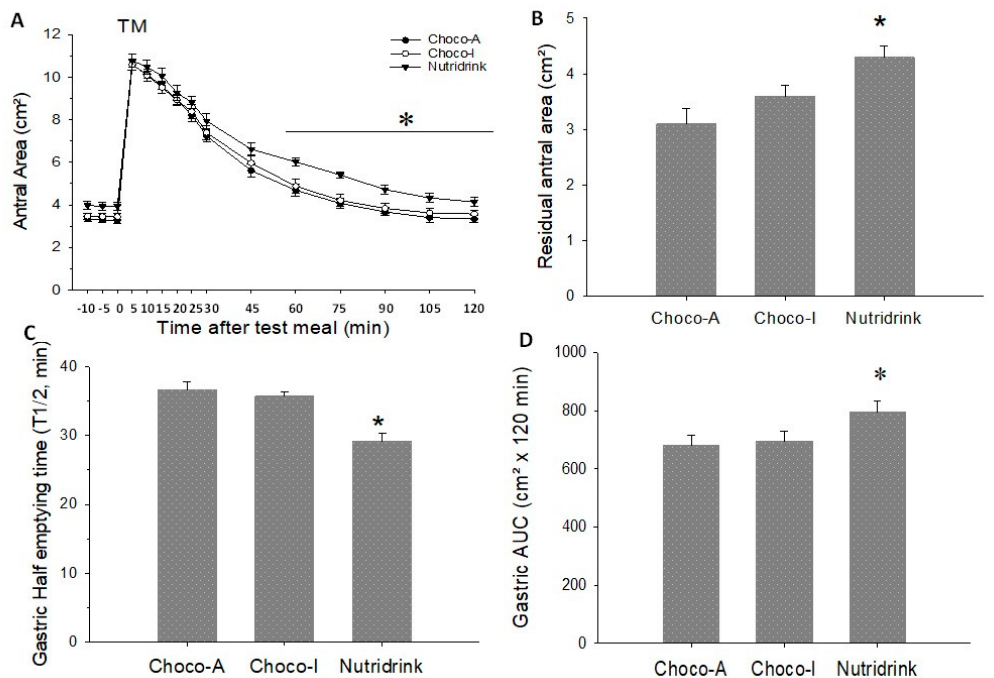
Figure 6. Gastric emptying parameters in response to ingestion of chocolates and test meal. ( A ) Time-dependent changes of antral area as cm 2 ; ( B ) Residual antral area as cm 2 ; ( C ) Half-emptying time as min; ( D ) Area under emptying curve (AUC). Data are expressed as means ± SEM. * p < 0.05 vs. Choco-A and